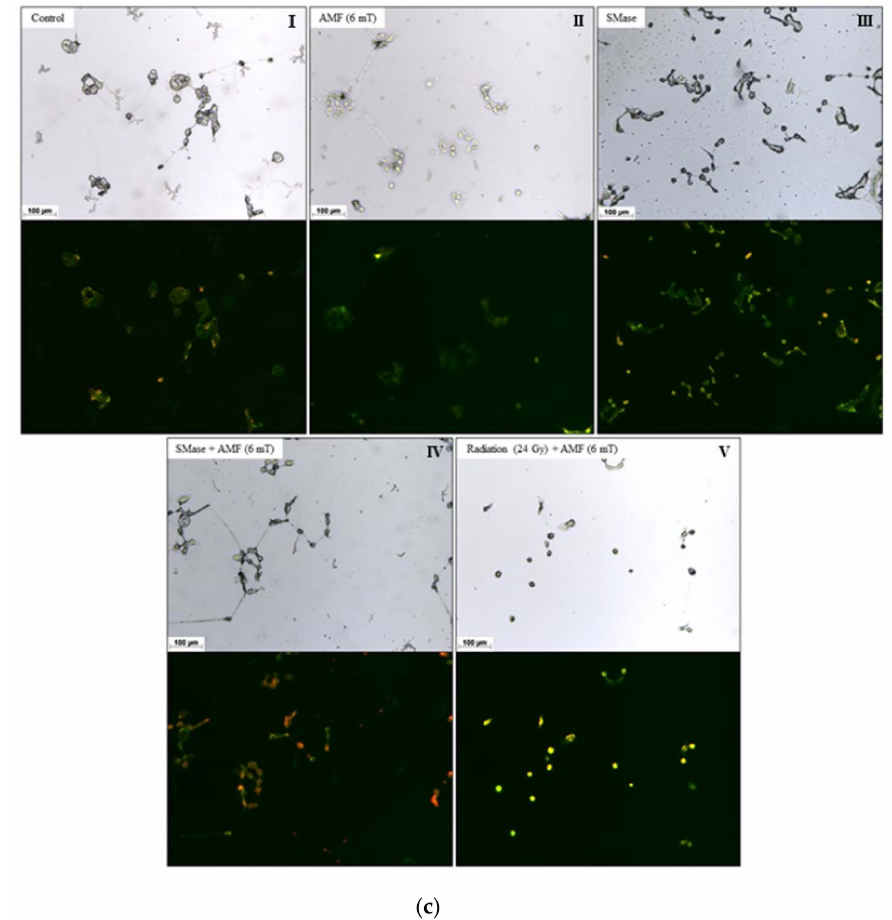
Figure 2. SCC cell images were observed by confocal microscope (63 × ). ( a ) Cellular interaction of SCC cells with the fluorescently (TeXas-Red PE) labeled SM-liposomes loaded with ferric nanoparticles and calcein. After the addition of the liposomes, the cells were exposed to SMase, AMF, or combined treatments. After the treatment, cells were washed and fixed with 4% PFA. Control cells that had liposomes without extra treatment (panel (I)) were observed with confocal microscopy and combined green (calcein drug mimic) and red (Texas Red liposomes) fluorescent images. Confocal image of the SCC cells after liposomes containing o,8-PE on the lipid membrane, and calcein as a payload. In the images, red-orange shows the liposome attachment to the cells after heavy 24 Gy radiation and AMF and nontreated control. ( b ) Quantification of calcein from the confocal images of the cells to show cell uptake of liposomal calcein cargo after induction of SMase by the stressed SCC cells as units / 100,000 cells. Images were taken with a confocal microscope, and quantification of the freed payload was measured by calcein signal in the cells. SMase 0.4 U / mL was incubated 30 min before measurement, and in the AMF treatment, 6 mT 20 min was used. Di ff erent radiation times were used to determine the e ff ect of spontaneous SMase after radiation stress and AMF in the release of liposomes. ( c ) Cellular interaction of SCC cells with the fluorescently (TeXas-Red PE) labeled SM-liposomes loaded with ferric nanoparticles and calcein. After adding the liposomes, the cells were exposed to SMase, AMF, or combined treatments. After the treatment, cells were washed and fixed with 4% PFA. Control cells that had liposomes without extra treatment (panel (I)) were observed with light microscopy and combined green (calcein drug mimic) and red (Texas Red liposomes) fluorescent images. Panel (II) presents cells that were treated with AMF (6 mT) after liposome addition, and Panel (III) presents cells treated only with sphingomyelinase (0.4 U / mL) after liposome addition. Panel (IV) presents combined treatments of SMase (0.4 U / mL) and AMF (6 mT). Panel (V) shows cells treated first with 24 Gy radiation, followed by the addition of liposomes and AMF